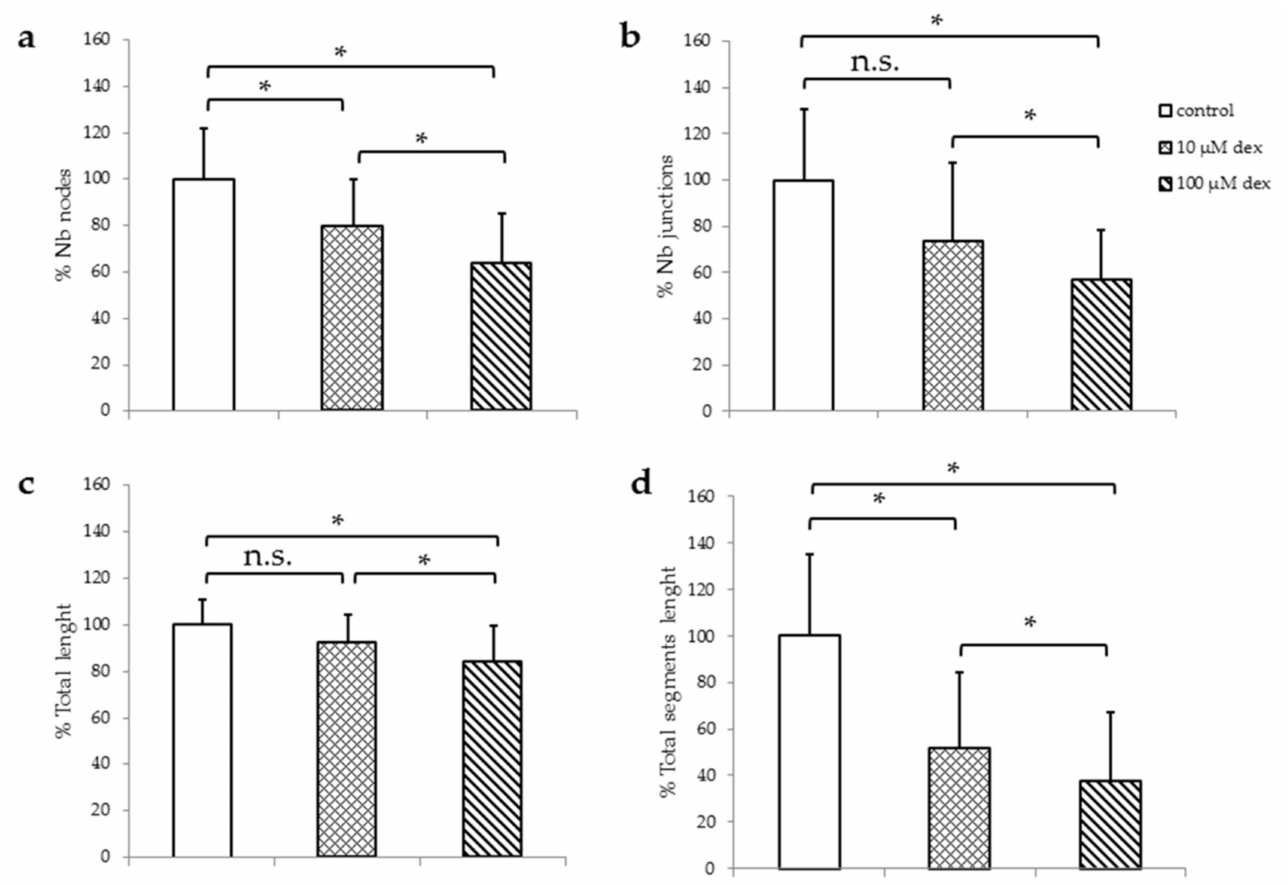
Figure 2. TLS assay of HUVECs after 24 h in HM1 with 10 and 100 µ M dex. Results are presented as bar charts; error bars show the standard deviation ( n = 3). Quantitative analyzes were performed for number of nodes ( a ), number of junctions ( b ), total length ( c ), and the total segments length ( d ). Data were normalized to a control of 100%. A p value < 0.05 indicate statistical significance (* p < 0.05), n.s. =